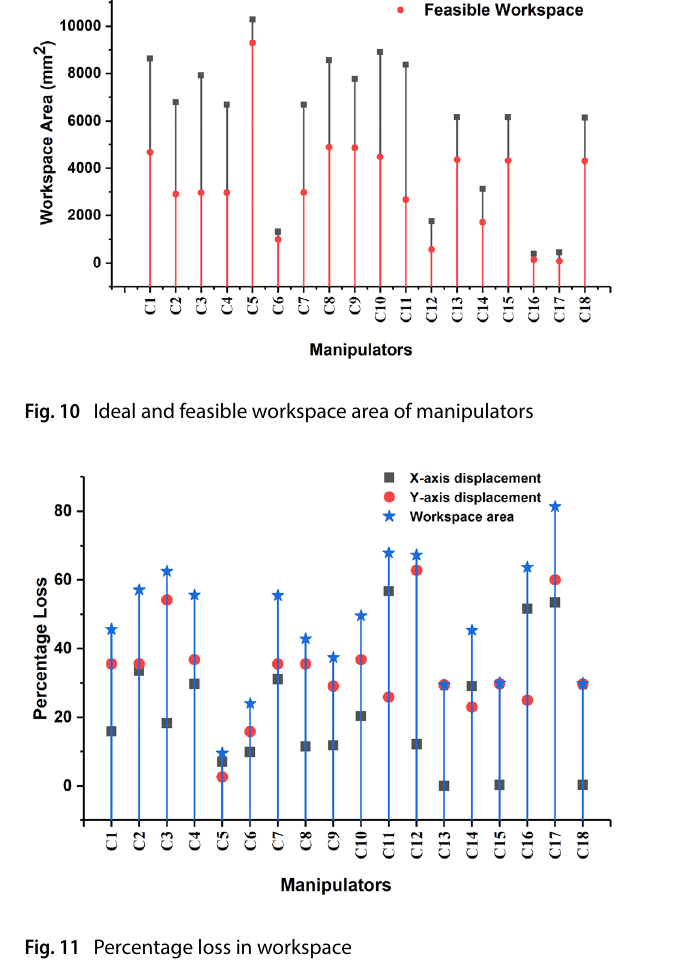
Fig. 11 Percentage loss in